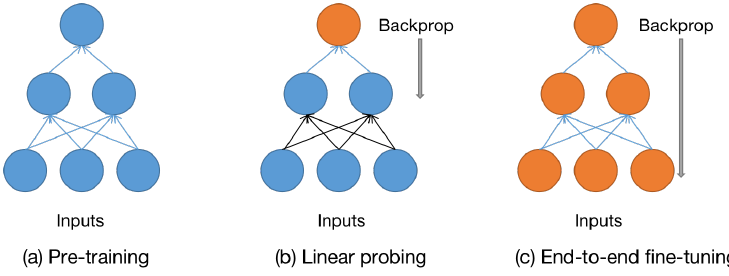
Figure 4. Gradient calculation and parameter update under different methods of self-supervised learning: ( a ) pre-training on unlabeled dataset; ( b ) linear probing; ( c ) end-to-end